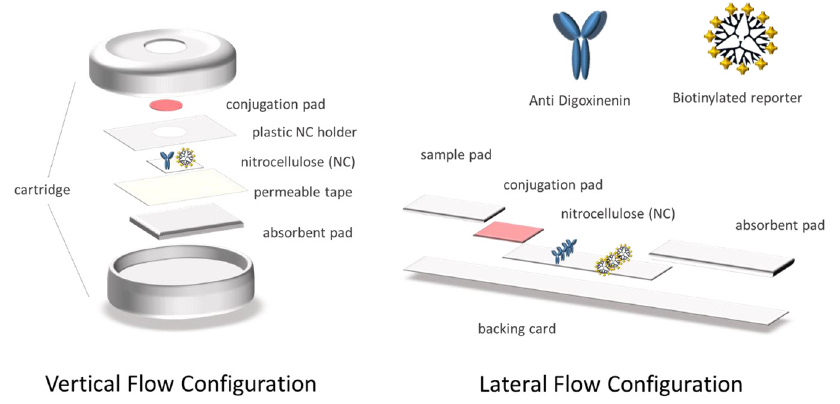
Figure 1. Schematic representation of the components forming the vertical and lateral flow configuration.